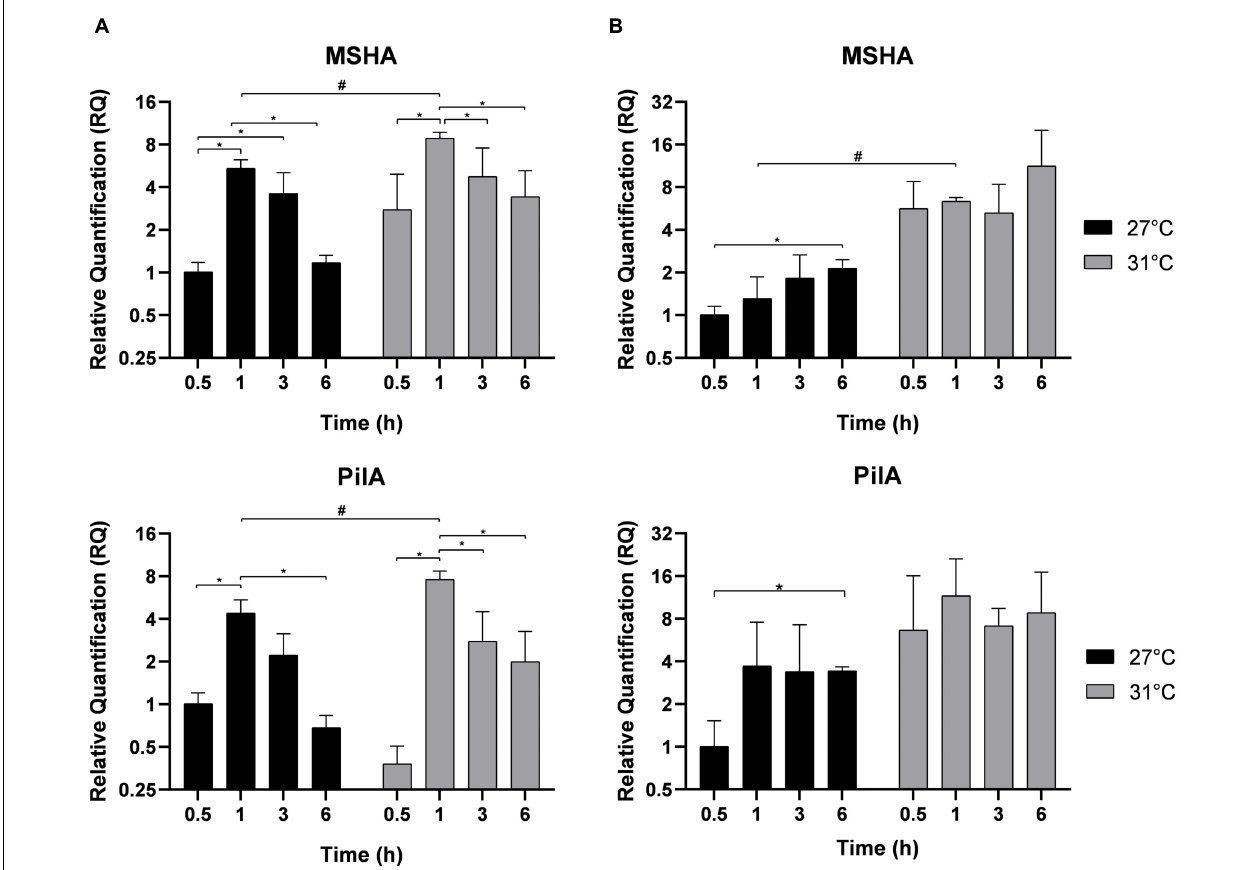
FIGURE 4 | Biofilm genes expression MSHA and PilA in free-living V. parahaemolyticus (A) and adherent bacteria (B) incubated at 27 ◦ C (black) and 31 ◦ C (gray). Bacteria were maintained 0.5, 1, 3, and 6 h in different conditions before RNA extraction from free-living bacteria and adherent bacteria in same well. Relative quantification expressions are expressed as means ± standard deviations of results from experiments performed with three replicate samples. # Significant difference between temperatures. *Significant difference between time